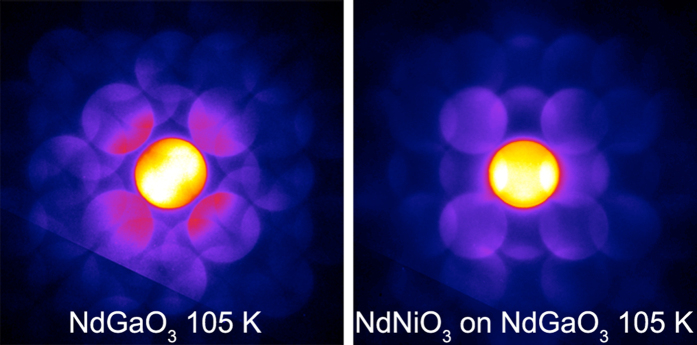
Low temperature LA-PACBED patterns from the NdGaO3 substrate and NdNiO3 film.While the substrate pattern is similar to its room temperature counterpart, the low temperature film displays a different symmetry from both the room temperature film and the substrate.